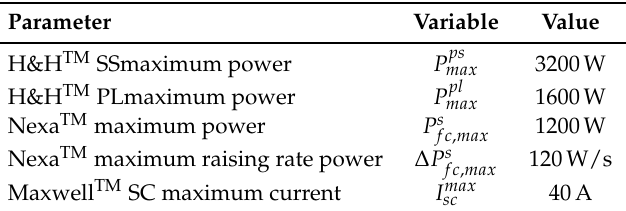
Table 7. Fuel cell test station rated values.